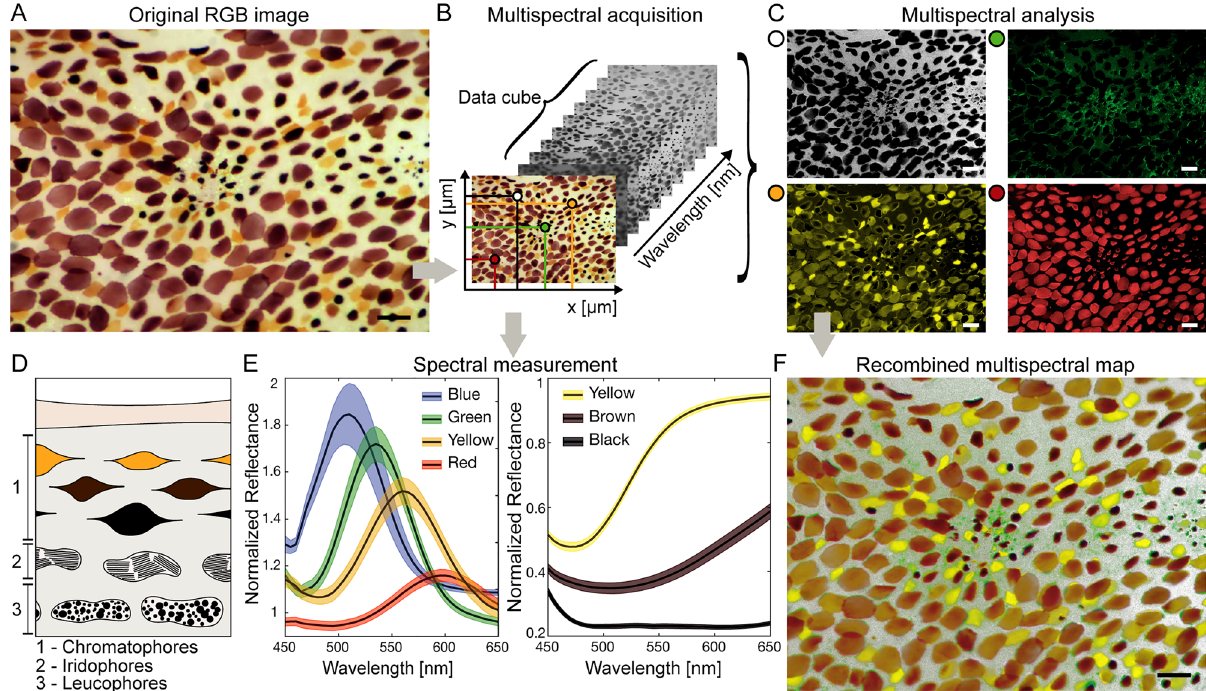
Figure 1: Multispectral analysis of octopus skin. (A)TheoriginalRGBbrightfieldreflectanceimageoftheoctopusskinispartofthe(B)multispectralacquisitionoftheskin,whichconsistsina data cube of the reflectance response within a specific wavelength range for every pixel of the image. The multispectral analysis allows to (C) isolate the spectral response or relevant optical elements of the skin, in this case belonging to (D) the chromatophores (yellow and brown dots), the iridophores (green dot), and the bare skin (white dot), which are labeled according to (E) their average reflectance as a function of wavelength.Thereflectancespectraarenormalizedwithrespecttotheresponseofaregionoftheskinwithnochromatophore/iridophoreand the shaded regions correspond to the standard error of the mean. The combination of the (C) individual spectral maps leads to the (F) recombined multispectral map. Scale bar: 200